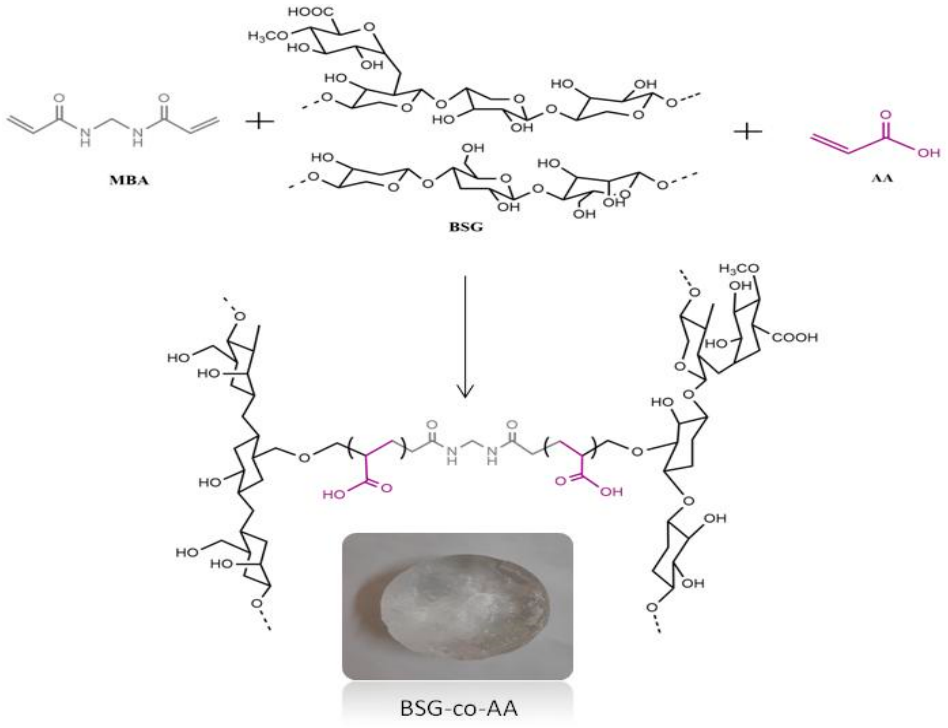
Figure 1. Chemical structure of polymer (BSG), monomer (AA), cross linker (MBA) and possible cross – linked structure of BSG–co–poly (AA) hydrogel.